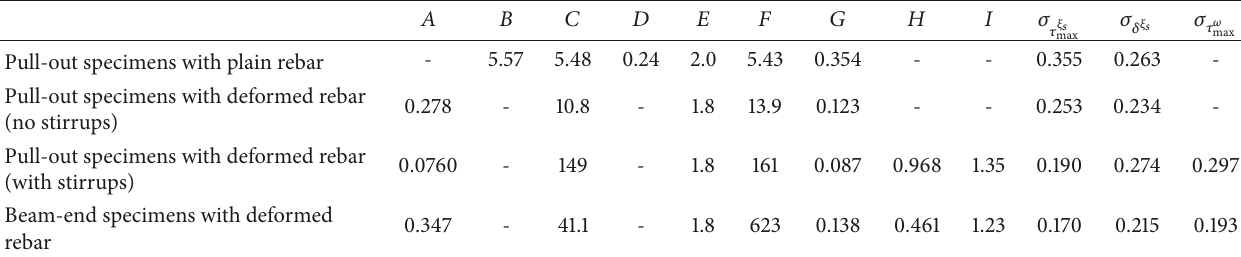
Table 4: Variables and standard deviations of the proposed stochastic